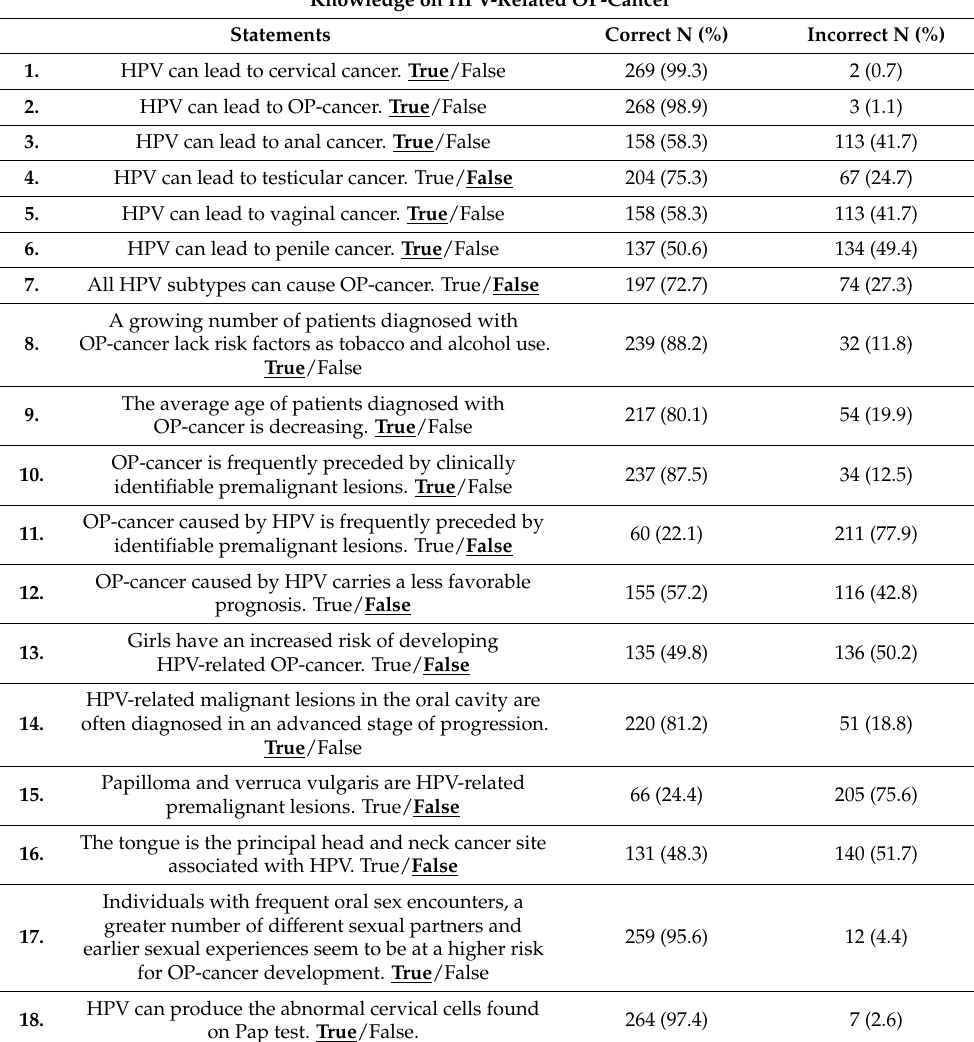
Table A1. Survey responses assessing pediatric dentists’ knowledge on HPV-related